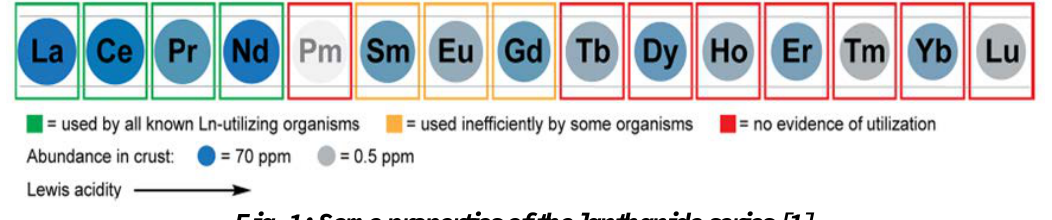
Fig. 1: Some properties of the lanthanide series [1].